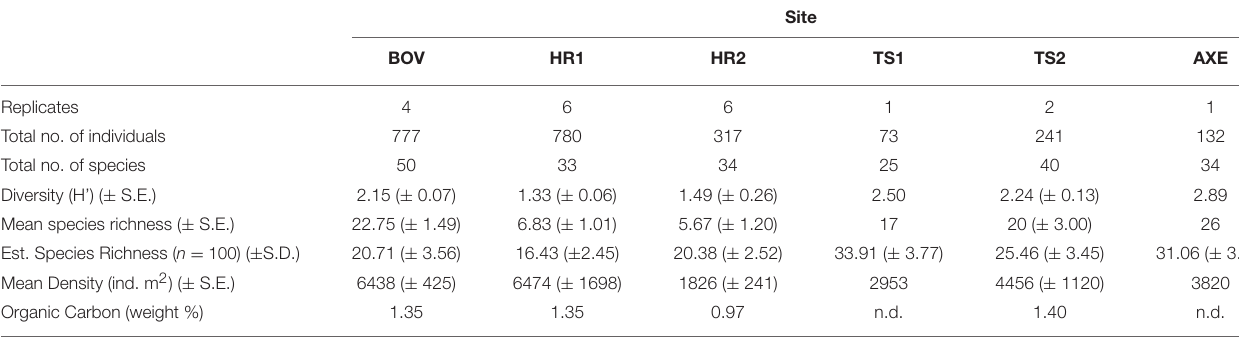
TABLE 2 | Species diversity and mean and estimated richness (for species-level discriminated fauna only), total density and organic carbon levels in the Bransfield